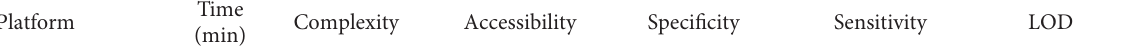
Table 2: Comparison of the current method with the commercial technologies for miRNA detection.